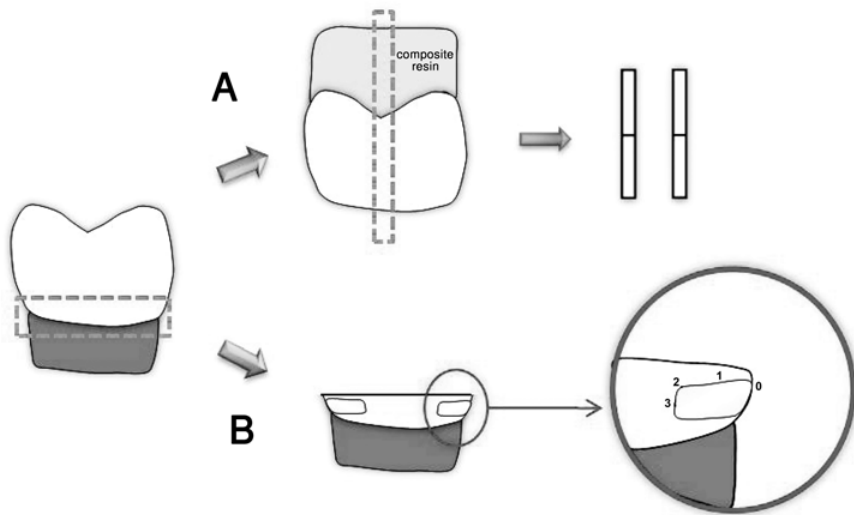
FIGURE 1- Summary diagram of test design (adapted from Sano, et al.